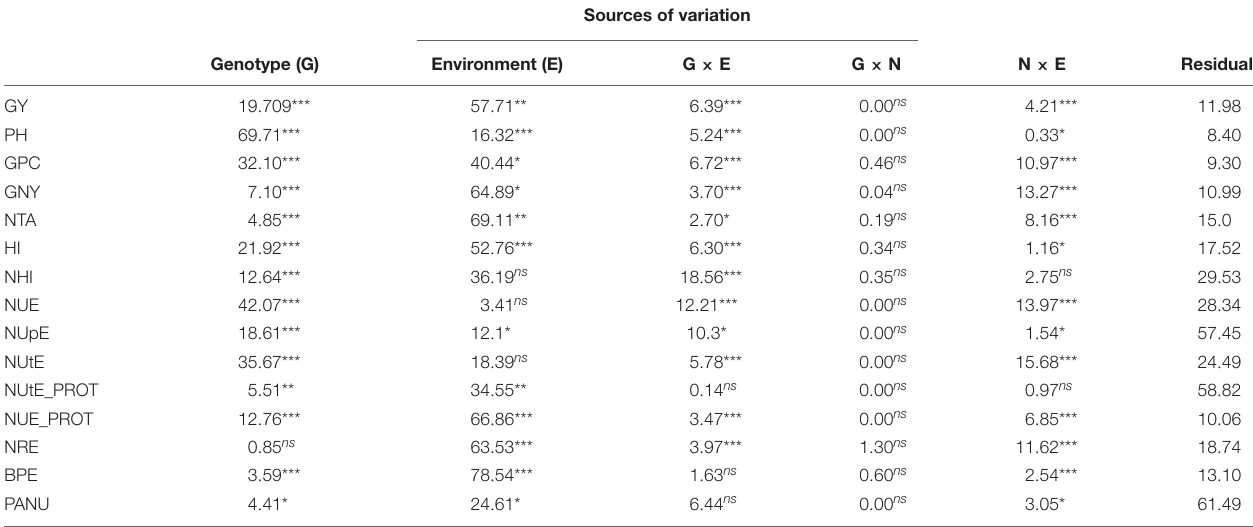
TABLE 3 | Contribution of different sources of variation (%) to total variation of analyzed traits across six environments and two nitrogen levels. Sources of